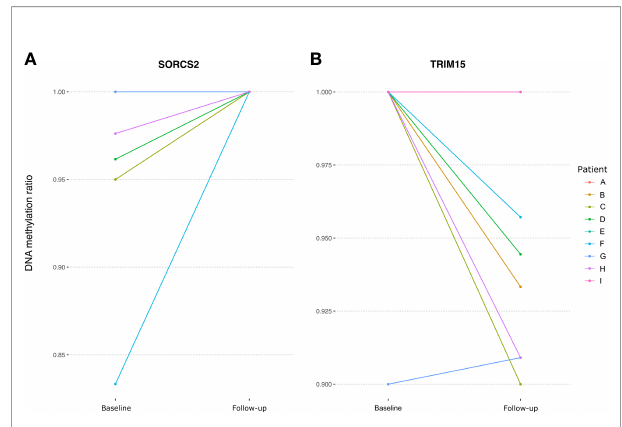
FIGURE 3 | Spaghetti plots showing the change in DNA methylation in RA patients at a DMP located in (A) SORCS2 and (B) TRIM15 between baseline and follow-up. RA; Rheumatoid arthritis, DMP, Differentially methylated position; SORCS2, Sortilin Related VPS10 Domain Containing Receptor 2; TRIM15, Tripartite Motif Containing 15.